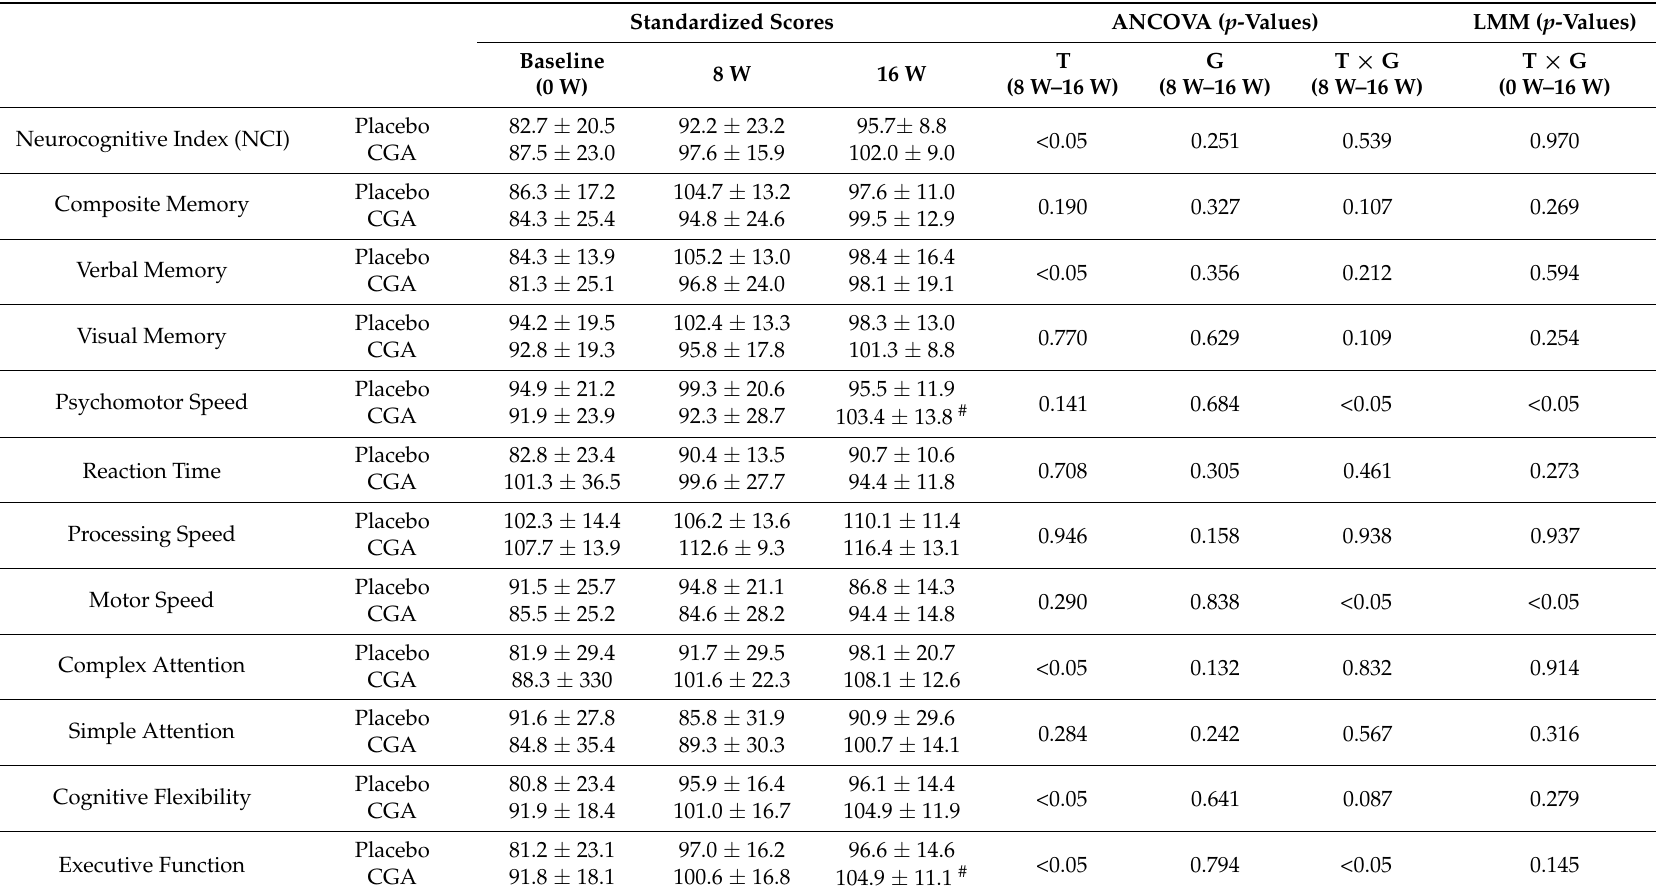
Table 3. The cognitive domain scores calculated in